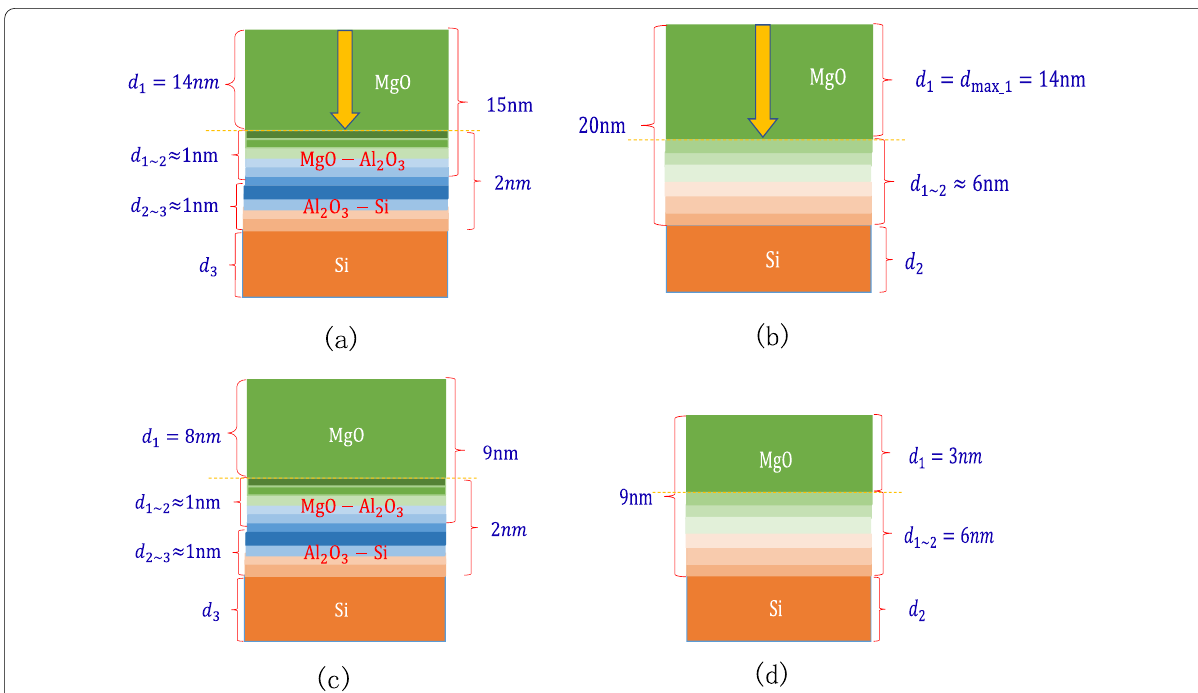
Fig. 18 Schematic diagram of the thickness of each layer of a multilayer structure, a shows the thickness of Al 2 O 3 /MgO (on the silicon wafer, grow 2 nm-Al 2 O 3 , and then grow 15 nm-MgO), b shows the thickness of MgO (on the silicon wafer, grow 20 nm-MgO), c shows the thickness of Al 2 O 3 / MgO (on the silicon wafer, grow 2 nm-Al